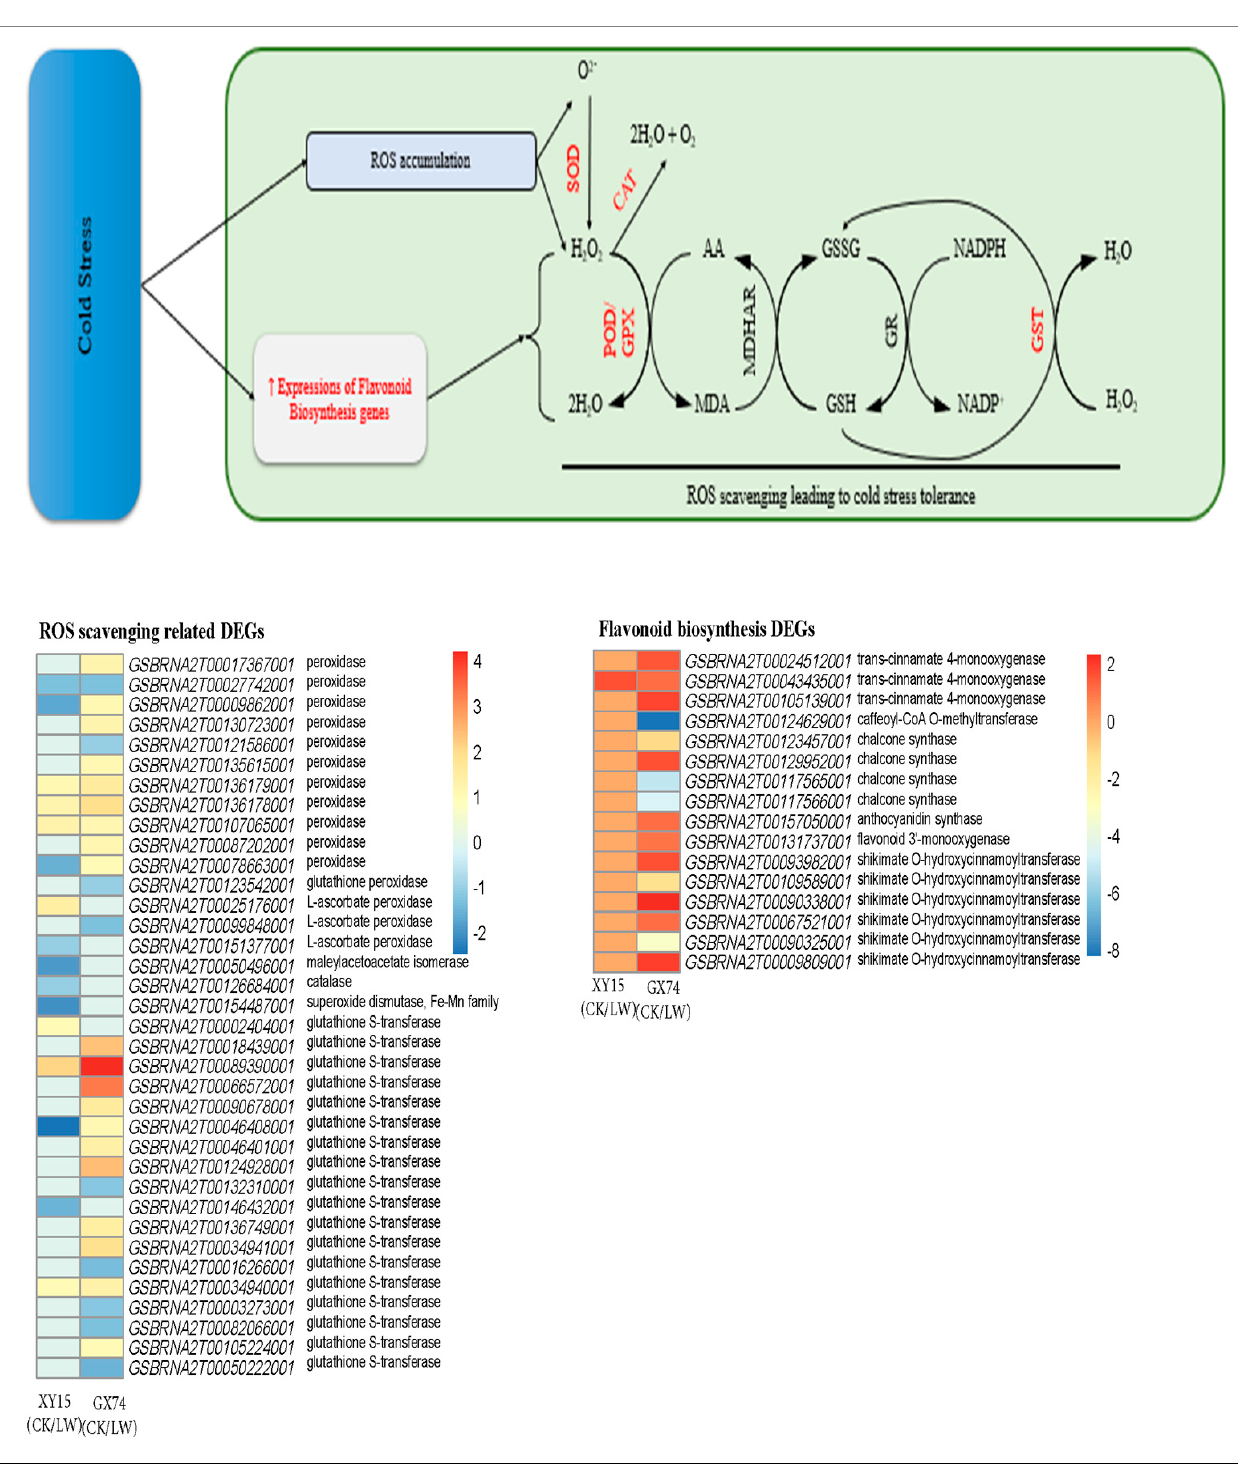
Figure 6. Reactive oxygen species scavenging related gene expression changes in XY15 (cold-sensitive) and GX74 (cold-tolerant) rapeseed siliques after cold-stress treatment. The genes highlighted as red text were differentially expressed. GR: glutathione reductase; MDHAR: monodehydroascorbate reductase; GPX: glutathione peroxidase; SOD: superoxide dismutase; CAT: catalase; GSH: reduced glutathione; GSSG: oxidized glutathione; MDA: monodehydroascorbate; and AA: ascorbate (AA). The heatmap was drawn in Tbtools [27] using the log2 foldchange values of ROS-scavenging- and flavonoid-biosynthesis-related genes. CK and LW represent control and cold treatments. The gene name abbreviations refer to the full names presented in Table S5.